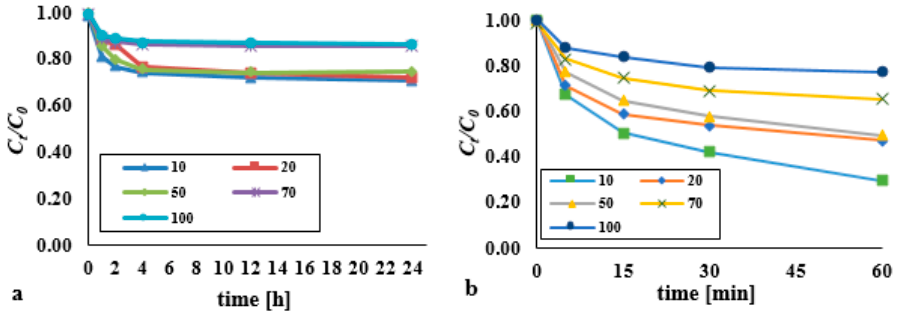
Figure 6. Influence of initial DEHP content on decomposition using ( a ) a modified Fenton process (pH = 3, molar ratio DEHP:H 2 O 2 :Fe 3+ 1:1:1); ( b ) a modified Fenton process supported by an ultrasonic field (pH = 10, molar ratio DEHP:H 2 O 2 :Fe 3+ 1:1:1, acoustic wave intensity — 3.97 W/cm 2 ).